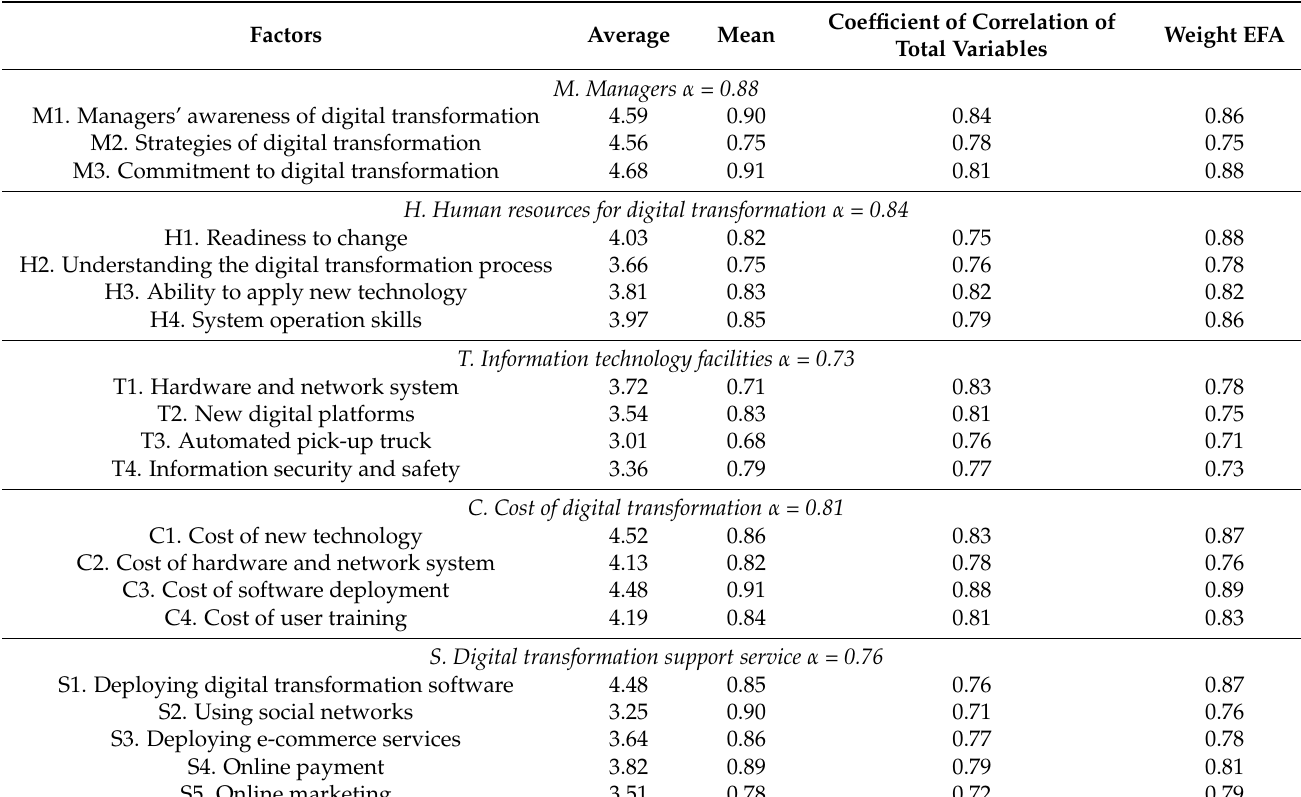
Table 2. The EFA and Cronbach Alpha Scale results.